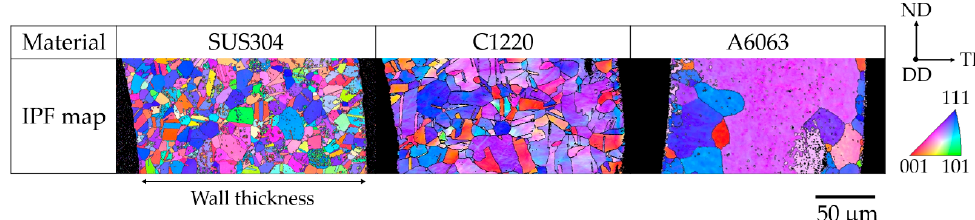
Figure 4. Inverse pole figure (IPF) maps of the starting materials. The symbols DD, TD, and ND indicate drawing direction, transversal direction, and normal direction, respectively. The grain boundaries were drawn on as black lines on IPF maps, using the OIM Analysis TM .